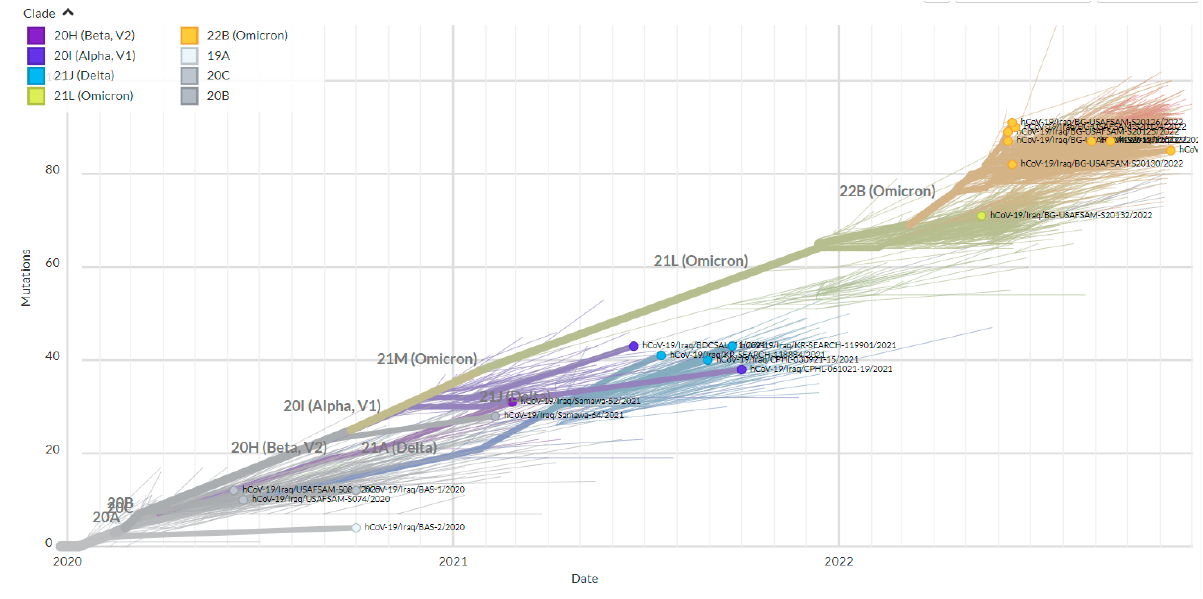
Figure 5. Nextrain phylogeny shows the time of identification of each clade in the Iraqi isolates.